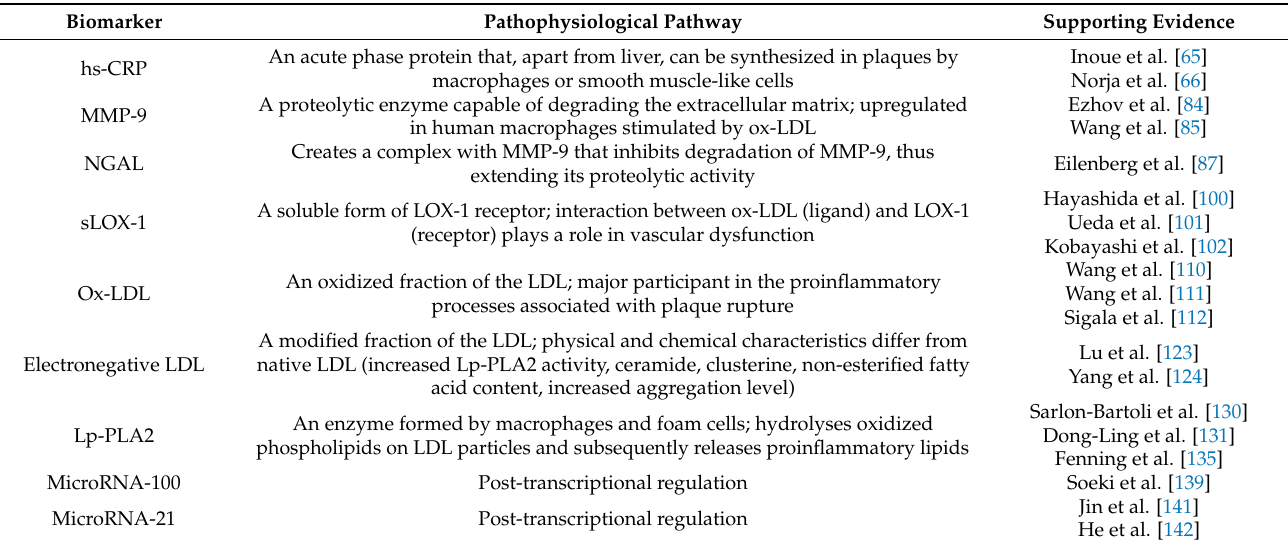
Table 1. Biomarkers in diagnostic approach to vulnerable